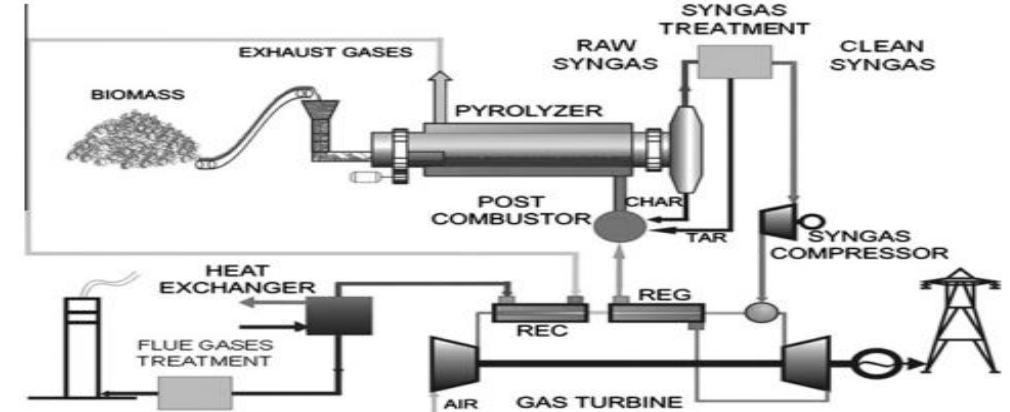
Figure 3: Representation of a pyrolysis process